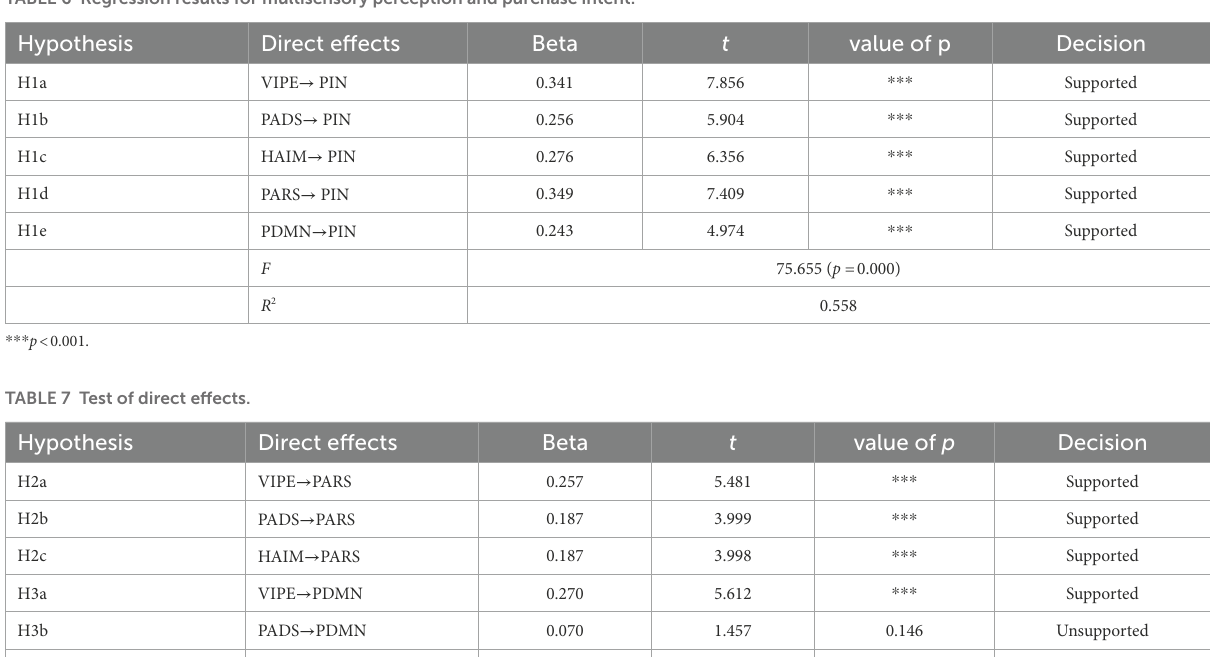
TABLE 6 Regression results for multisensory perception and purchase intent.